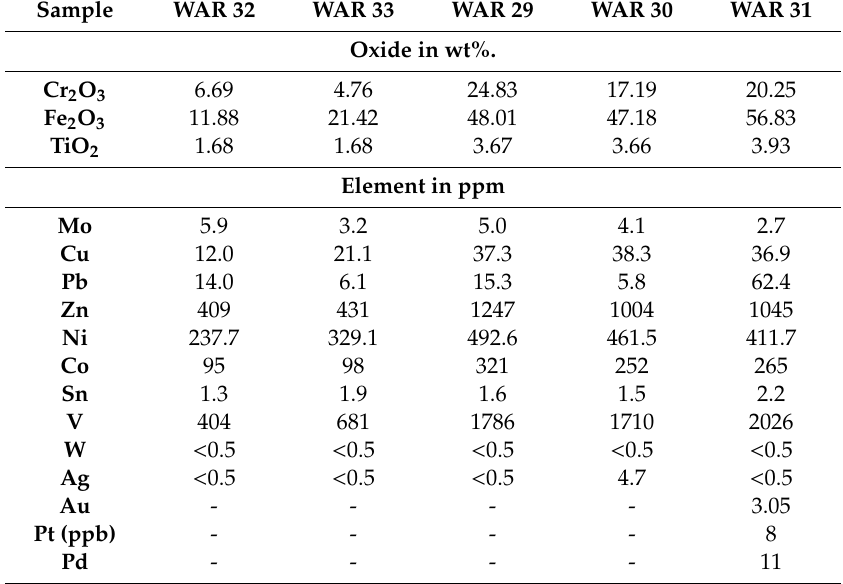
Table 4. Chemical composition of heavy minerals concentrate from the Botawa River. ICP-MS (Inductively coupled plasma mass spectrometry) analysis.